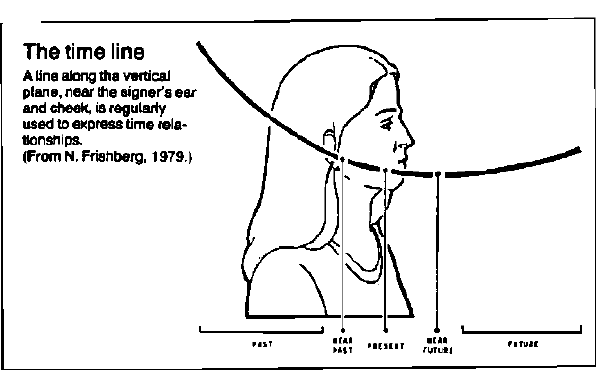
Figure 6a: Examples of nonmanual behaviour.